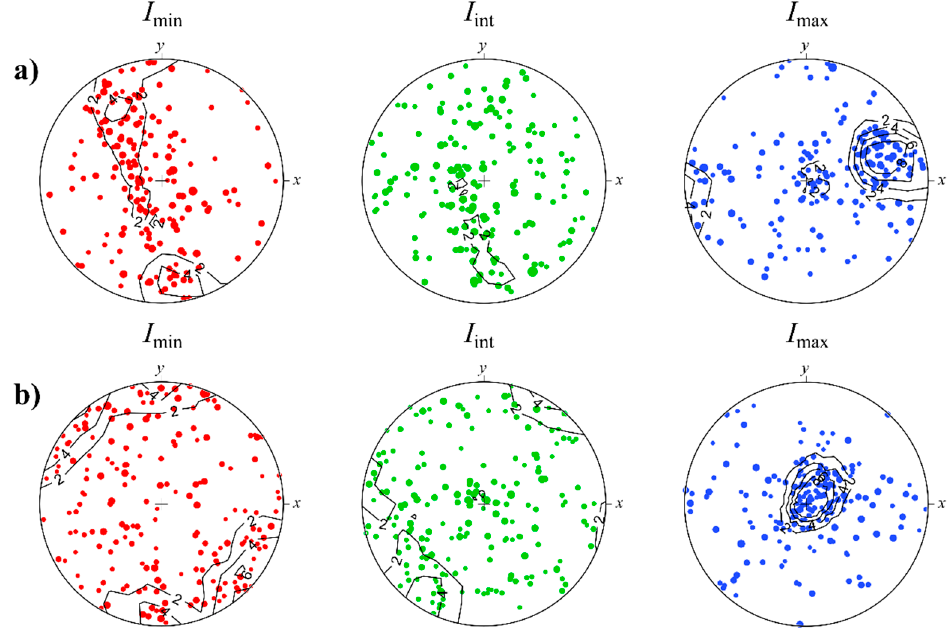
Figure 6. The upper hemisphere stereographic projections of principal axes of inertia tensor of inclusions in Sample_1 ( a ) and Sample_2 ( b ). The size of symbols is proportional to the equivalent diameter of particles. Kamb contours (E = 3 σ ) are shown at 2 σ , 4 σ , 6 σ , 8 σ levels.